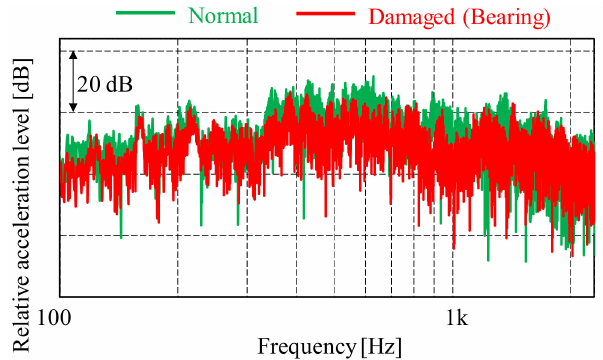
Figure 17. Comparison of the frequency characteristics of the vibration in the normal condition and when operating with a damaged bearing: This result shows that the characteristic di ff erence in the peak-dip tendencies received at R1 shown in Figure 15 is not observed; however, in the damaged-bearing condition, the energy level is approximately 5 dB lower than under the normal condition over the entire frequency